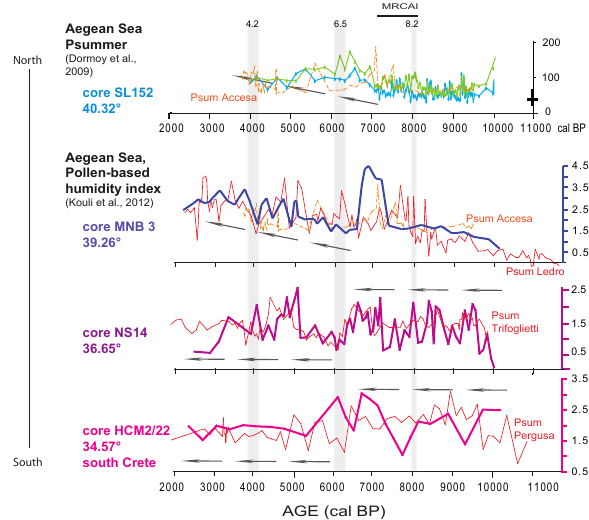
Fig. 7. Contrasting precipitation patterns in Italy and in Aegean Sea during the Holocene. Psum=Psummer (MAT only) as in Fig. 4, from each lake pollen record (dotted orange: Accesa; red: Ledro, Trifoglietti and Pergusa; units same as Fig. 6). Comparison with the Aegean Sea records. (1) Pollen-inferred sum- mer precipitation (in mm) for the marine core SL152, North Aegean Sea (Dormoy et al., 2009), obtained with the PLS method (green curve), and the NMDS/GAM (blue curve); (2) pollen-based hu- midity index established by Kouli et al. (2012) from three marine pollen records located across a north–south transect in the Aegean Sea: cores MNB3 (blue curve), core NS14 (purple curve) and core HCM2/22 (dark pink curve). Short events at around 8200, 6500 and 4200calyrBP are also plotted. MRCAI=period of maximal rate of change in annual